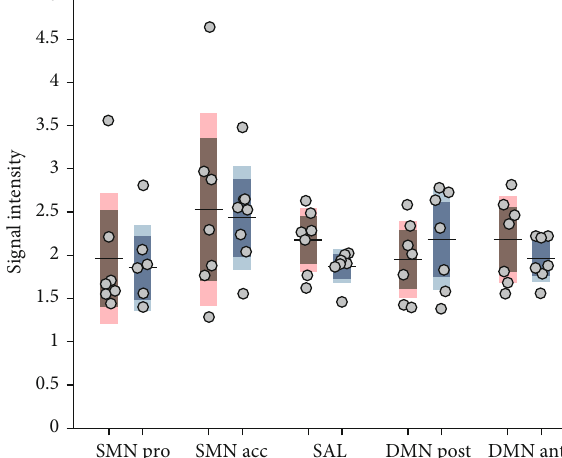
Figure 2: Median of signal intensities from back-reconstructed independent components, which is the physical measure of brain connectivity strength. The fi rst column within each network gives the values of capsaicin-sensitive subjects (red), and the second column gives the values of the control subjects (blue). Horizontal lines indicate the mean, grey boxes indicate 1 standard deviation from the mean, and colored boxes give the 95% con fi dence interval. DMN ant: anterior part of default mode network; DMN post: posterior parts of the default mode network; SMN acc: accessory sensorimotor network; SMN pro: proper sensorimotor network; SAL: saliency